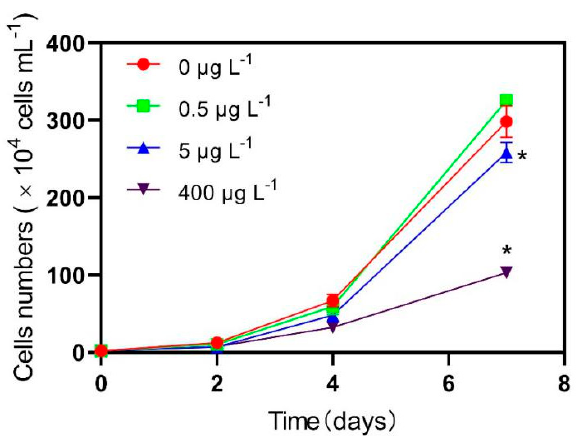
Figure 1. A 7-day growth inhibition plot of R. subcapitata . Asterisk (*) demonstrates a significant difference ( p < 0.05) in control and LIN dosing groups. Data expressed as mean ± SD of three parallel measurements (n = 3).